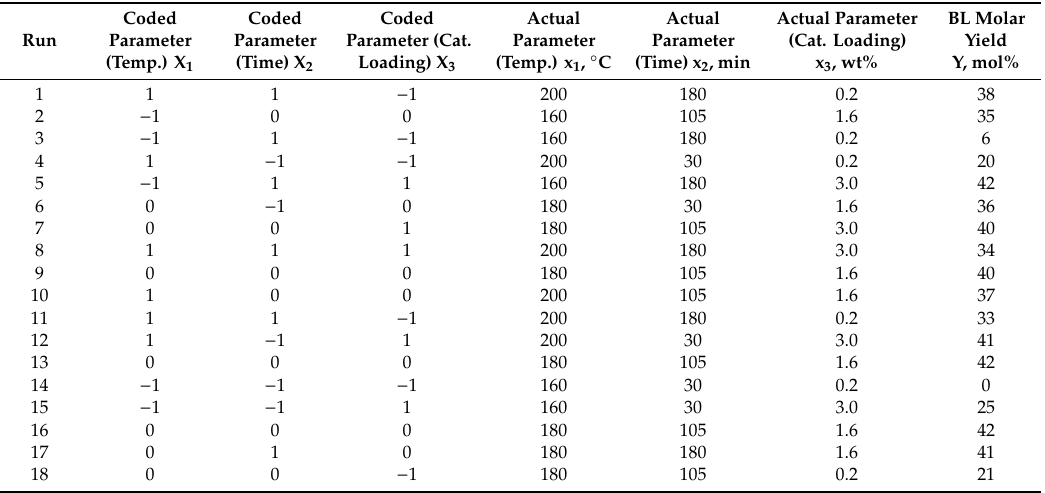
Table 4. Experimental design and BL molar yield (%) response of the Face-Centered Central Composite Design (FCCD) for di ff erent combinations of temperature, reaction time, and catalyst loading, all realized at the constant biomass loading of 20